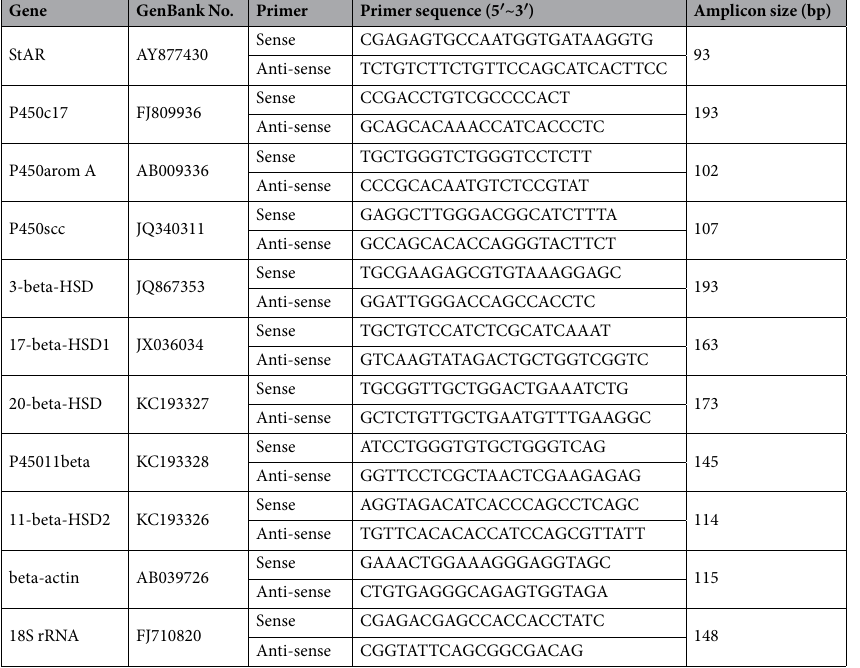
Table 3. Primers for real-time PCR